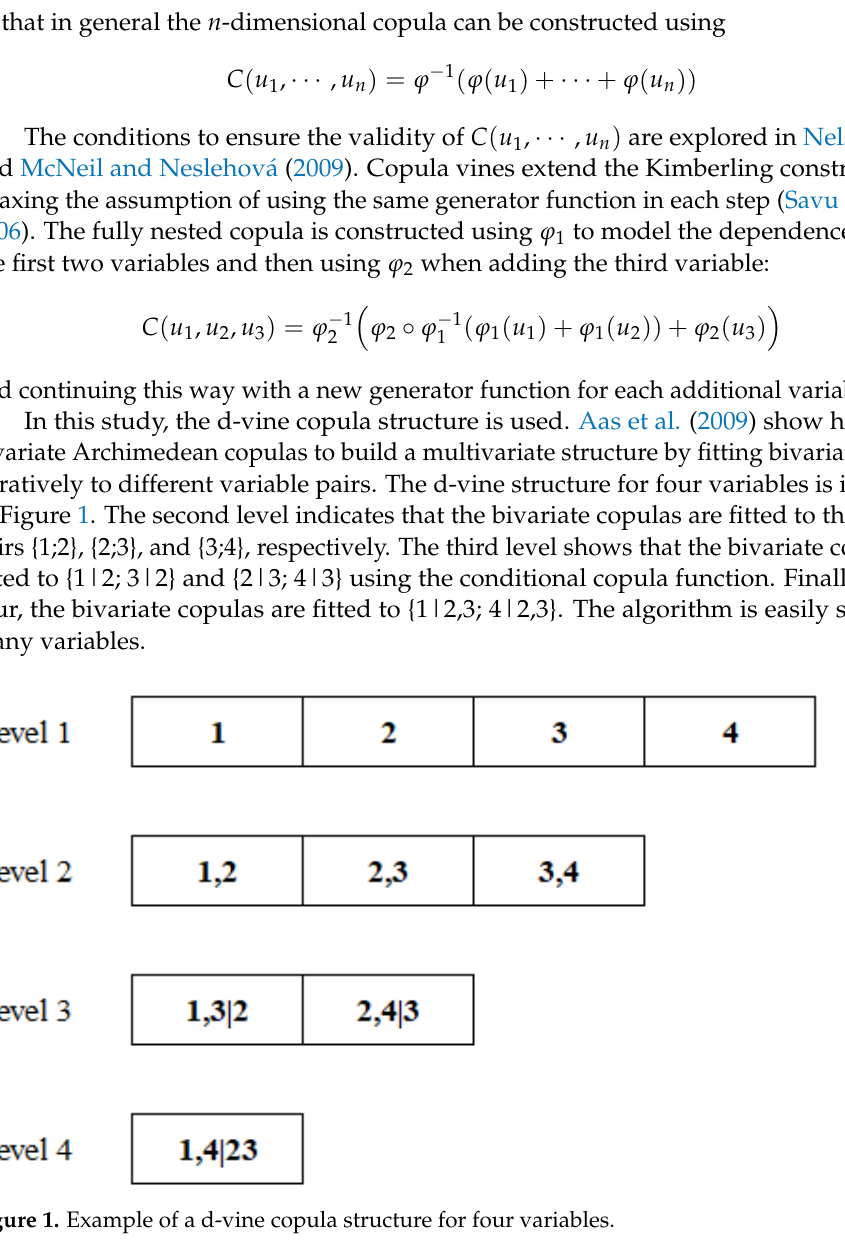
Figure 1. Example of a d-vine copula structure for four